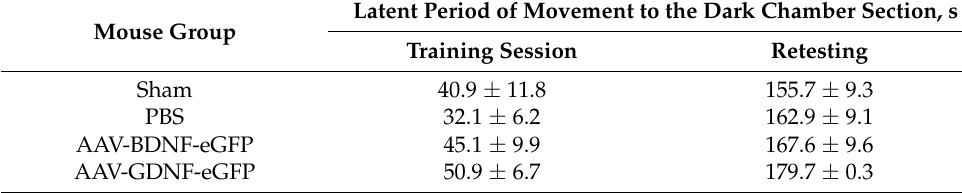
Table 2. Efficiency of reproduction of the conditioned passive avoidance reflex in mice after the modeling of audiogenic